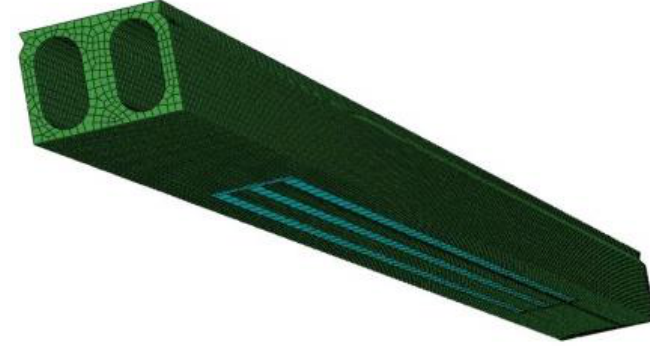
Figure 8. FE model of the strengthened beam.